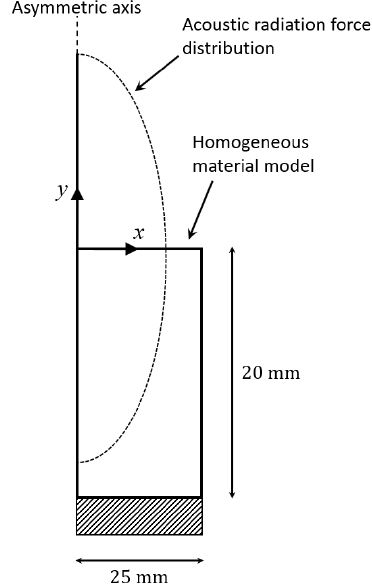
Figure 4. Illustration of the finite element model.